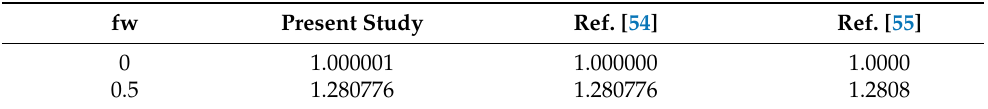
Table 3. Comparison of − f (cid:48)(cid:48) ( 0 ) for disparate values of fw with λ = Fr = Ha = φ = 0 to Prabakaran et al. [54], Ibrahim and Shankar [55].